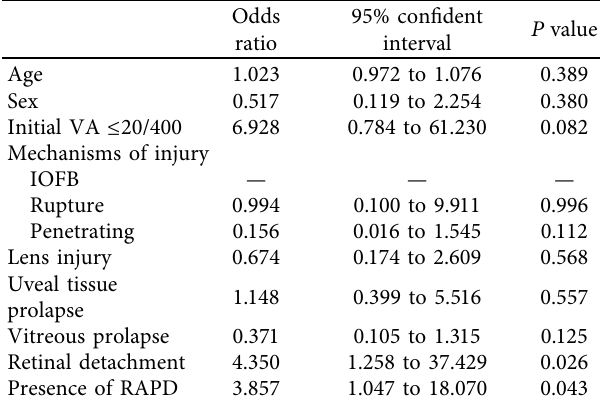
Table 3: Multivariable analysis for the factors related to poor visual outcome.